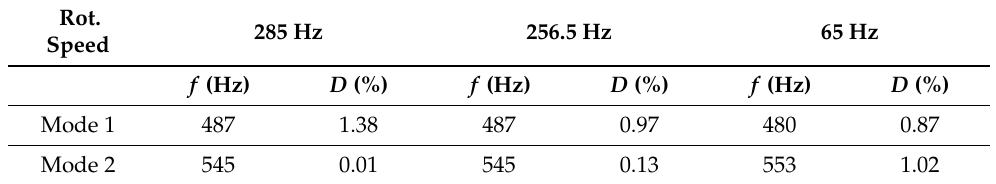
Table 4. Selected, robust eigenfrequencies in operation (Asb2).